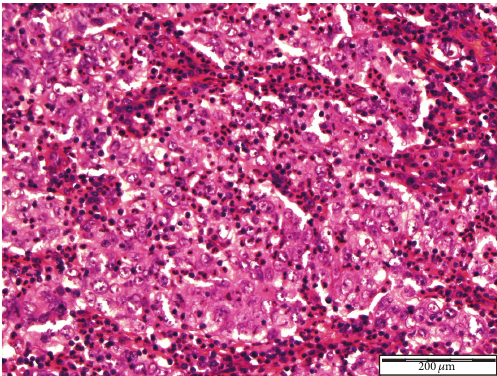
Figure 3: Lymphoepithelioma-like carcinoma of the urinary blad- der showing neoplastic cells with indistinct cell borders. The tumour cells are showing eosinophilic cytoplasm, large vesicu- lar nuclei, coarse chromatin, and prominent nucleoli Haema-